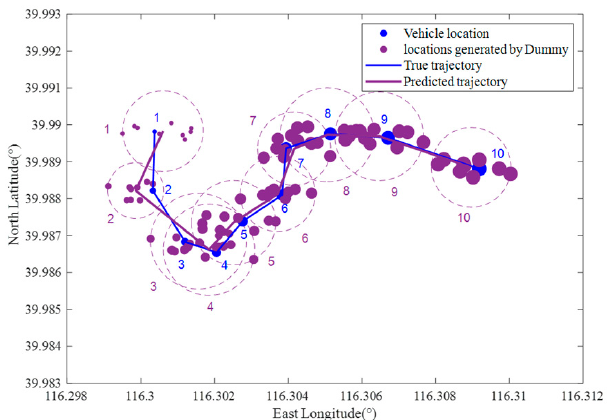
Figure 9. The predicted trajectory of a vehicle user with location privacy preservation method based on dummy locations.